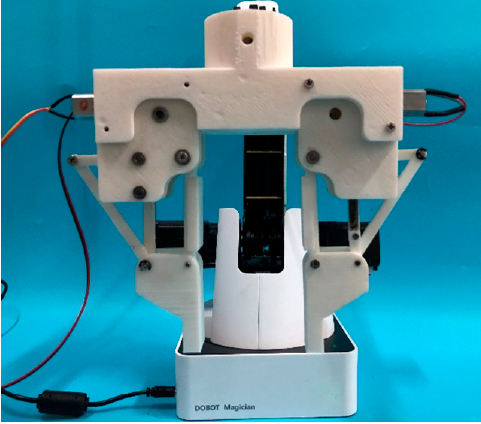
Figure 10. The prototype of the VGS hand.